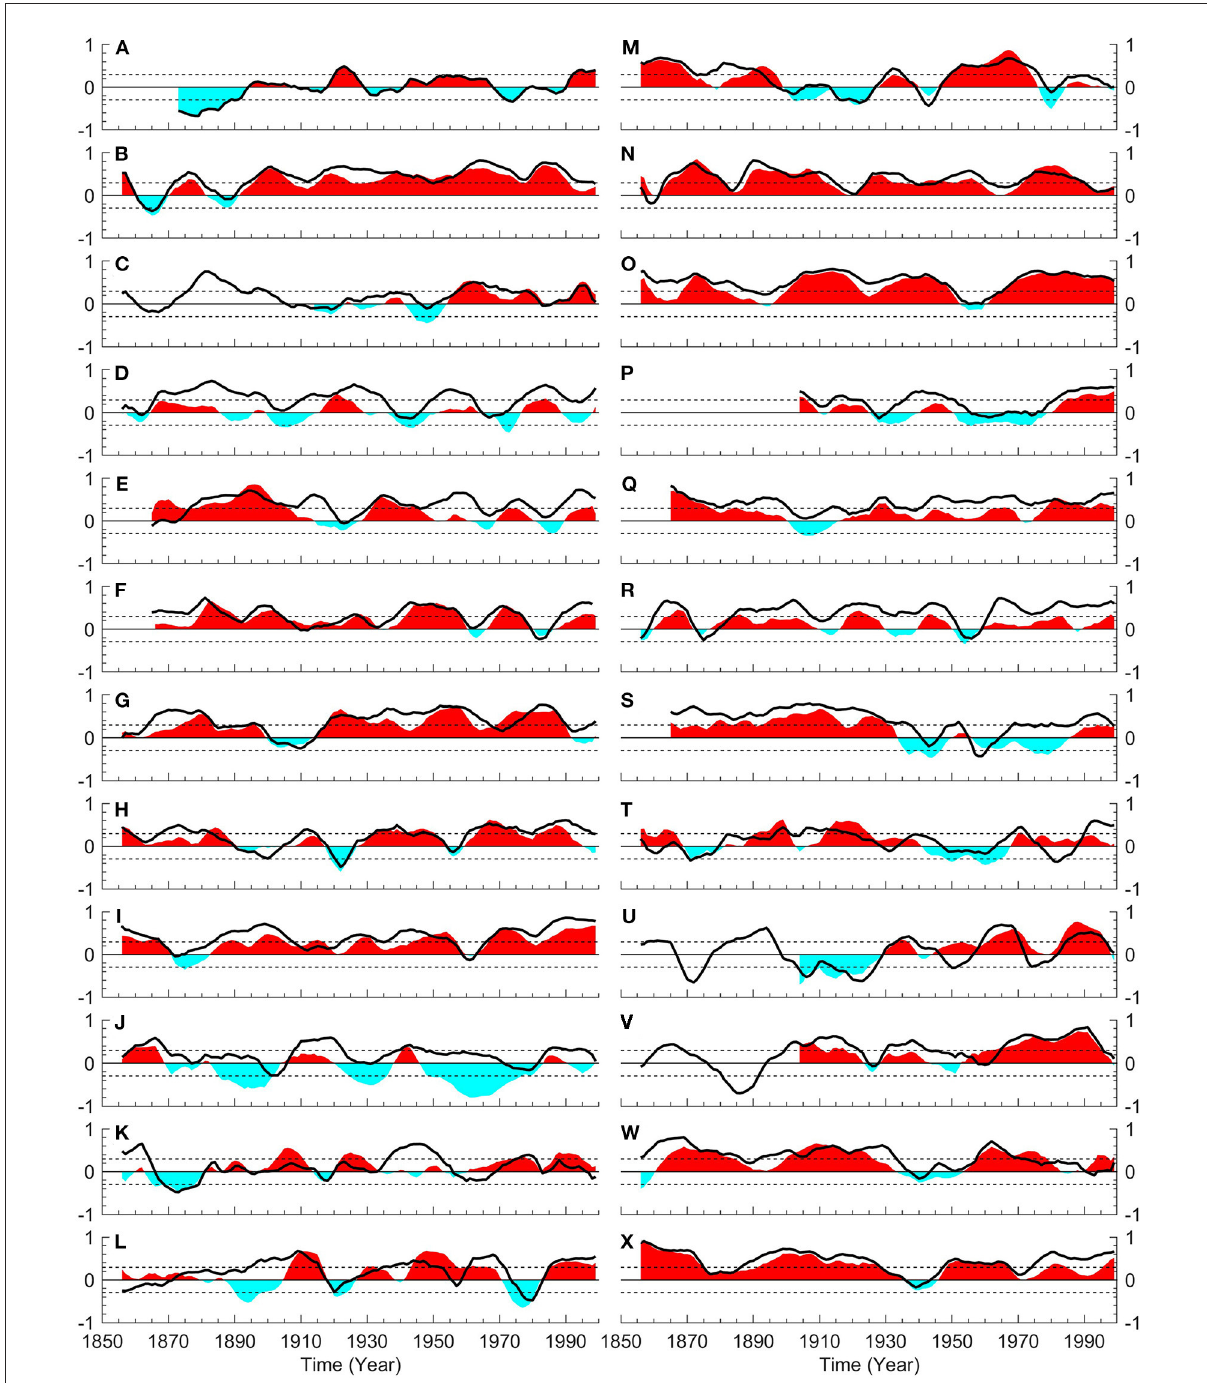
FIGURE1 Lag correlation between the STIO SSTA (SSHA) in fall and the SSTA (SSHA) in the Niño3.4 area in the next fall with a running window of 11 years in HadISST and CMIP5 historical simulations, the horizontal axis showing window central date. Shading and curves indicate correlation of SSTA and SSHA, respectively. Index (A–X) refers to different CMIP5 model as listed in Supplementary Table 1.